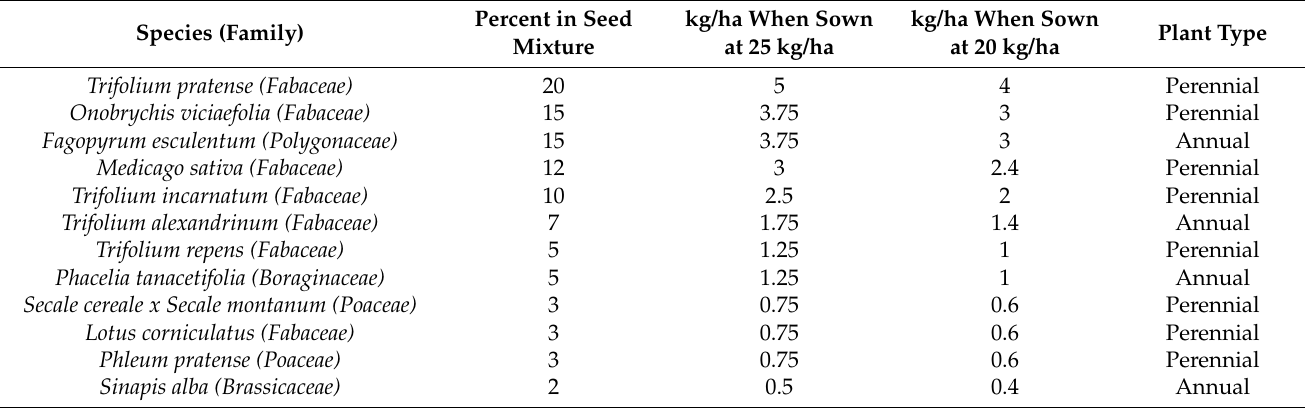
Table 1. The species composition of the Hungarian seed mixture for the Operation Pollinator flower margins surveyed in this study. Species were chosen that attract a range of pollinators, based on observations of pollinator visitation and foraging behaviour in earlier Operation Pollinator seed